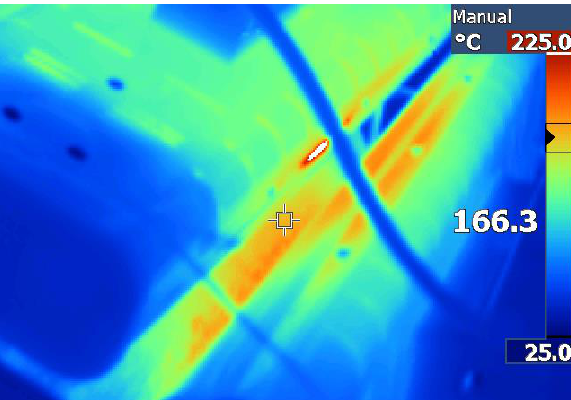
Figure 20. Thermal image of the roll temperature before the installation